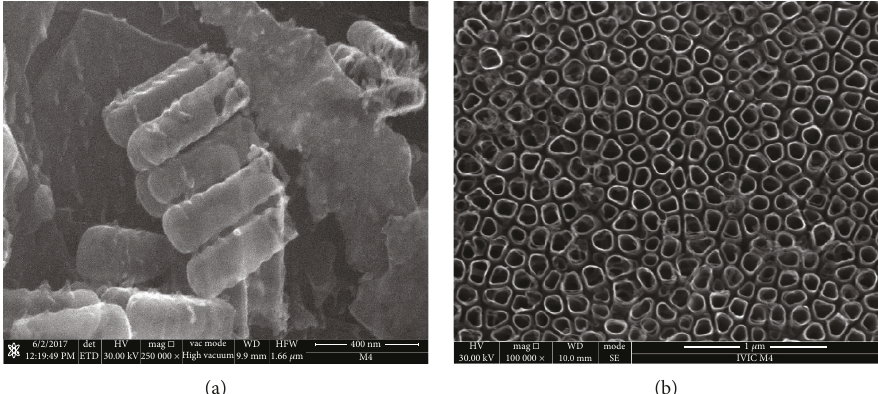
Figure 7: Experimental TiO nanotubes obtained after the anodization of Ti foil synthetized according to the methodology reported in 2